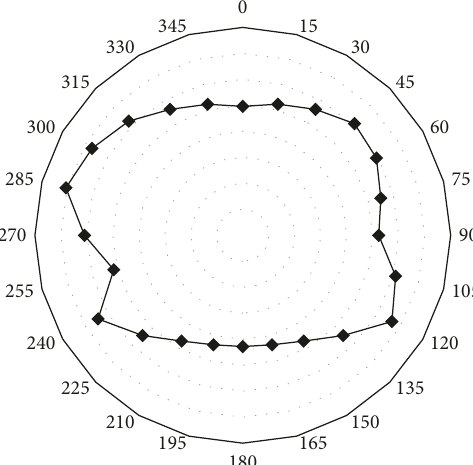
Figure 12: Comparison of jacket structure’s ultimate strength with various directional wave loads (direction angle is from 𝑥 -axis to 𝑦 -